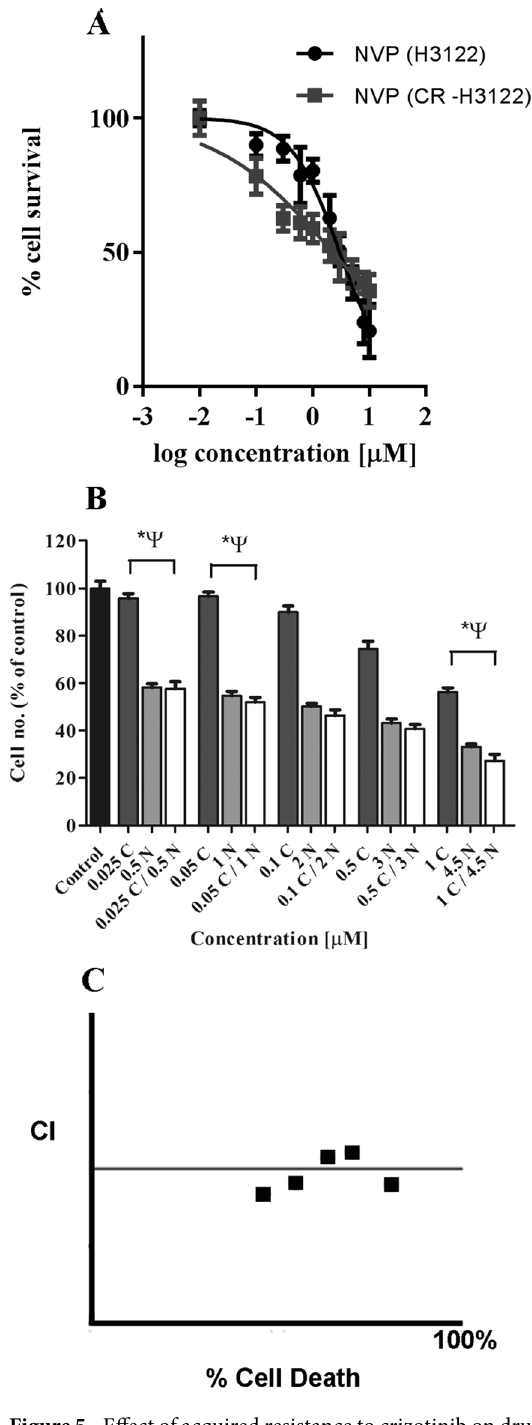
Figure 5. Effect of acquired resistance to crizotinib on drug cytotoxicity. ( A ) Cytoxicity for IGF-1R inhibitor NVP-AEW541 (NVP) H3122 and CR-H3122 cells. ( B ) Cytotoxicity of combination treatment by crizotinib and NVP-AEW541 on CW-H3122 cells. ( C ) Combination index plot for drug combinations in “B”. Conventions are as for Figs 1 and